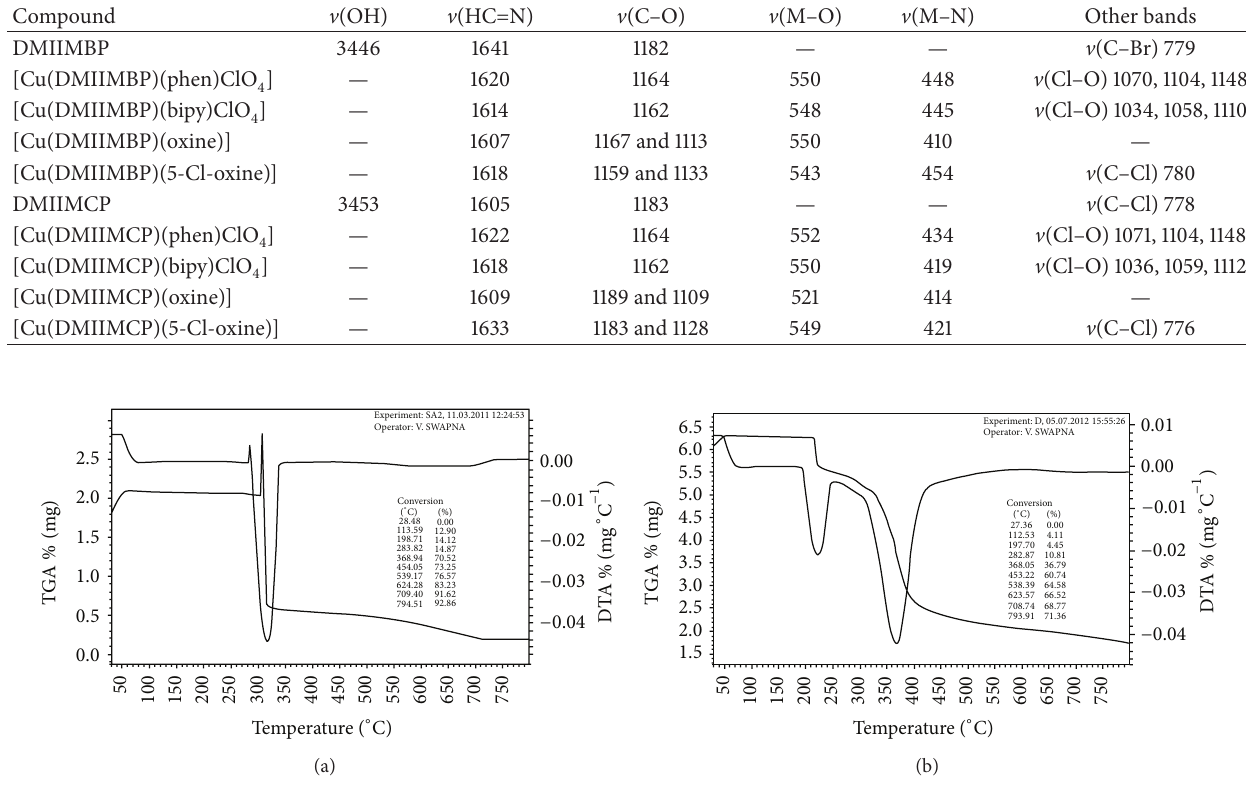
Figure 1: (a) The TGA spectrum of [Cu(DMIIMBP)(phen)ClO 4 ]. (b) The TGA spectrum of